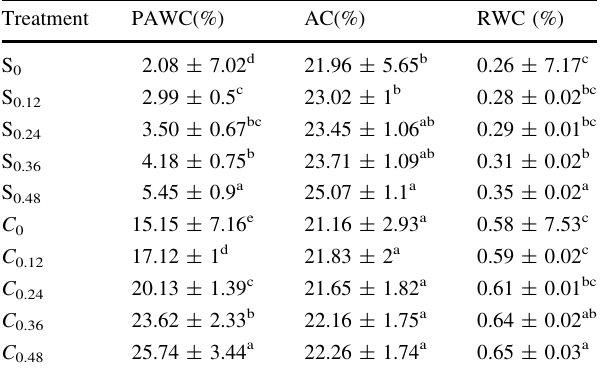
Table 4 Different soil water retention curve indices based on varying magnitudes of added crumb rubber